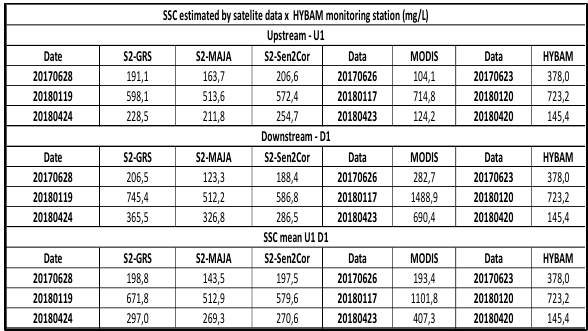
Table 3 – SSC estimated by satellite data x